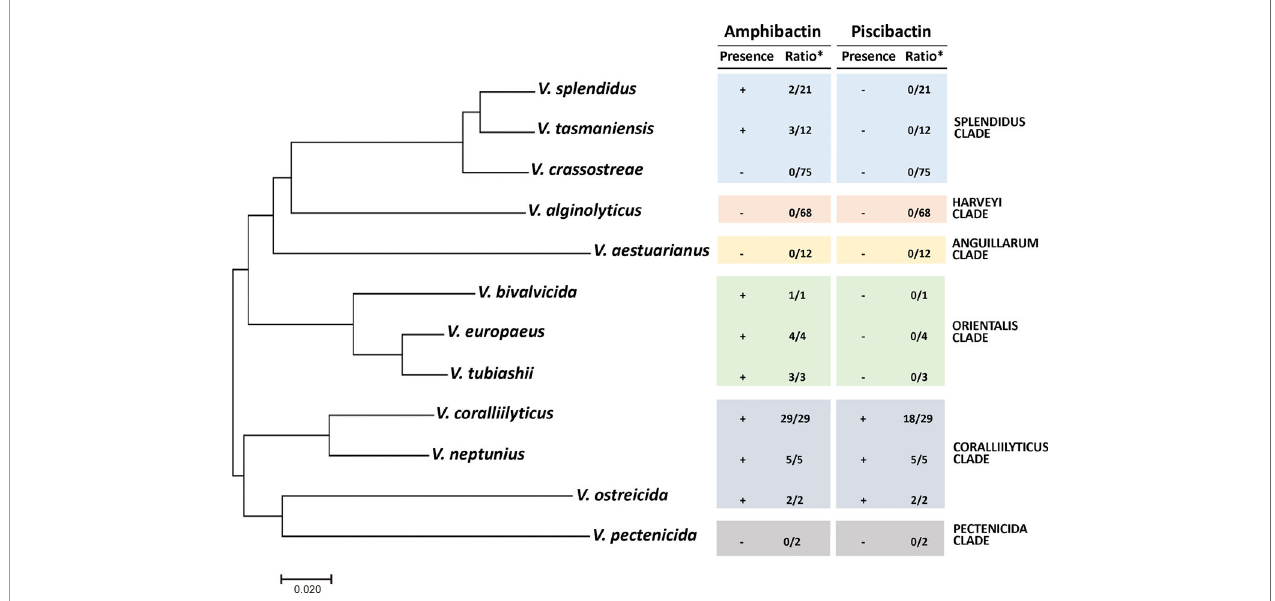
FIGURE 9 | Distribution of amphibactin and piscibactin siderophore systems in Vibrio species responsible for outbreaks in bivalves hatcheries. Presence (+) or absence (-) of complete piscibactin/amphibactin gene cluster determined by Blast search in WGS database indexed in the NCBI database using the nucleotide sequences of V. neptunius PP-145.98 as query. The ratio (*) indicates the number of genomes of a Vibrio sp. harboring close homologues with respect to the total number of genomes analyzed of that species. Phylogenetic tree was constructed by maximum-likelihood (GTR+G model) with the concatenated sequences of the fi ve housekeeping genes ftsZ , gyrB , mreB , pyrH and recA